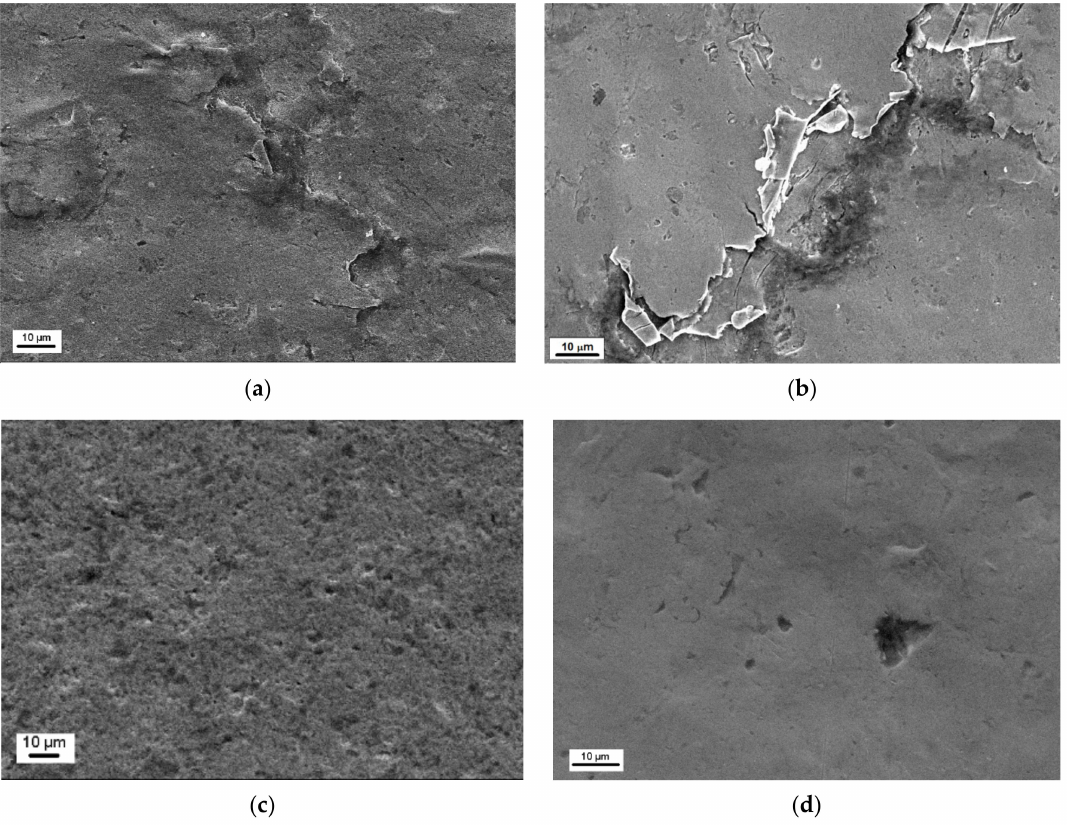
Figure 18. Surface damages developed during slurry erosion tests carried out at a rotational speed of 1012 rpm in ( a ) S235JR-AR steel and ( b ) S235JR-TT steel, and at a rotational speed of 565 rpm in ( c ) S235JR-AR steel and ( d ) S235JR-TT